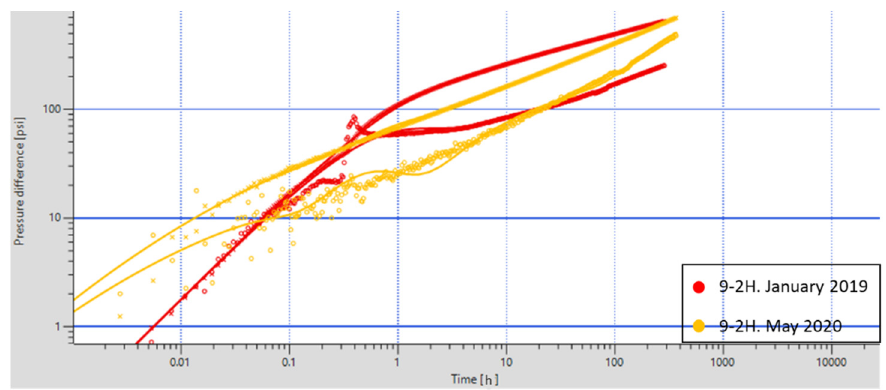
Figure 17. 9 ‐ 5H well test curve.